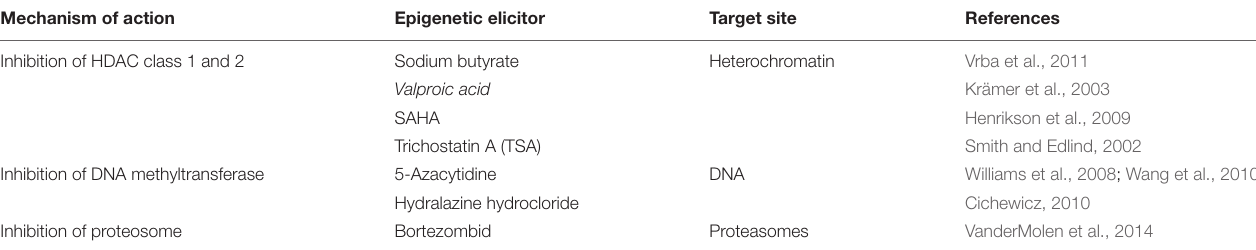
TABLE 1 | Small molecular compounds and their mechanism of